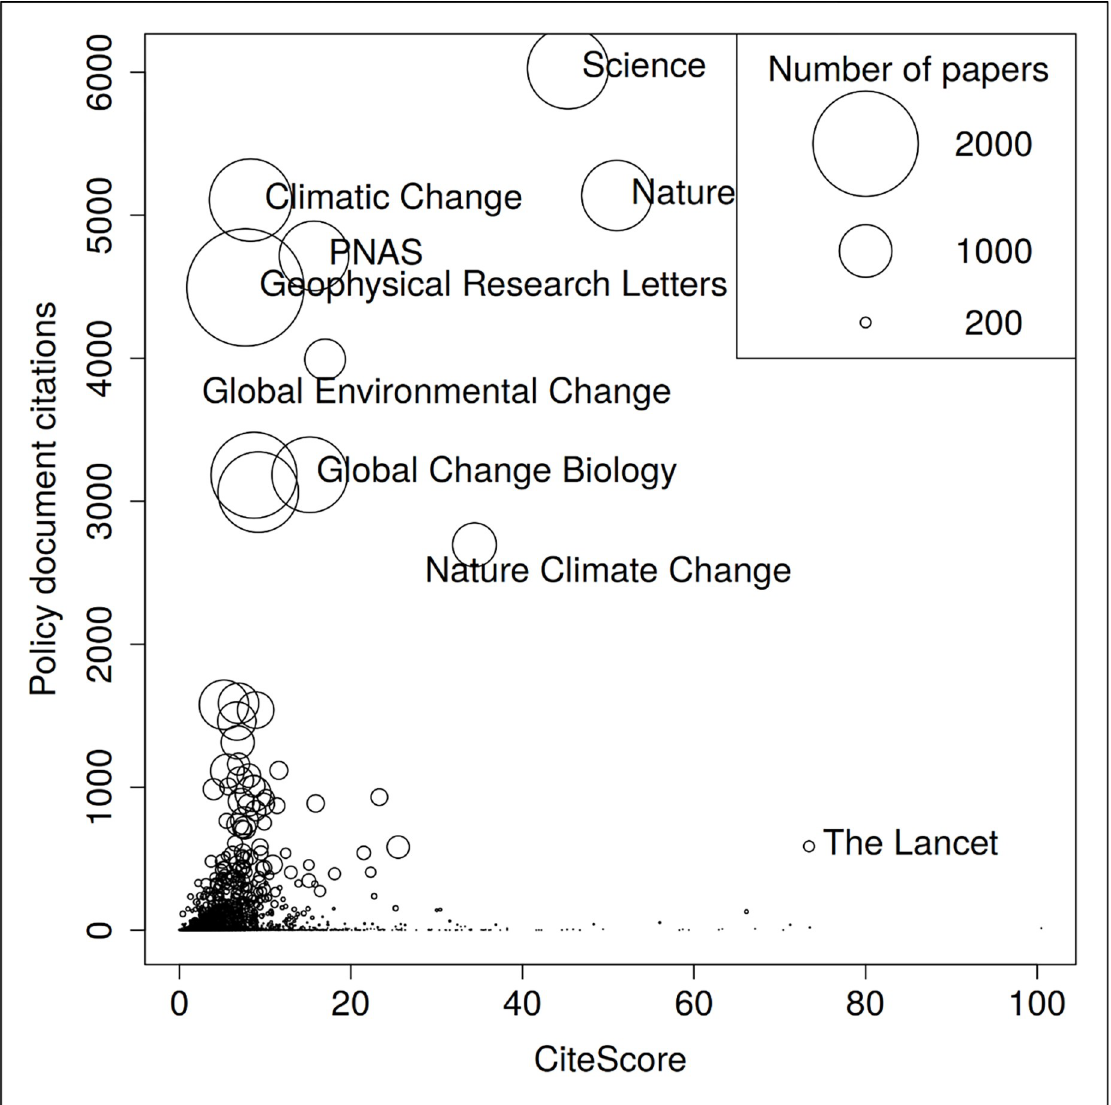
Fig 6. Correlation between number of climate change policy document citations received by papers in various scientific journals and number of Scopus papers published in these journals (Spearman rank correlation = 0.24; an interactive version can be viewed at: